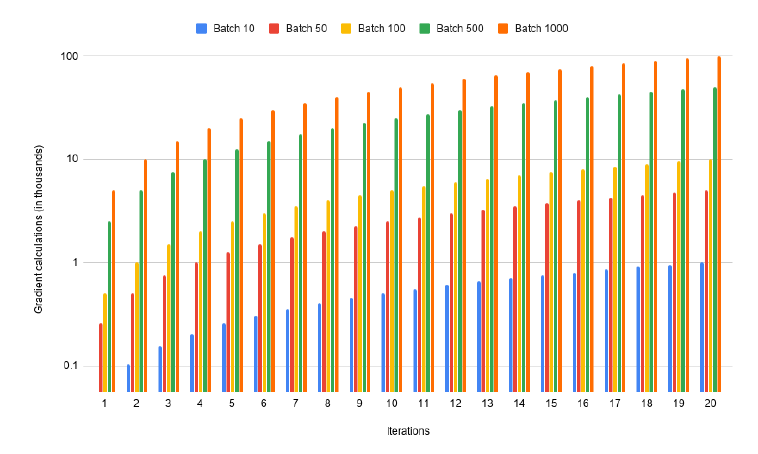
Figure 7. Number of detections done during training of the network with batch 100 and training of the network using modified algorithm with non-informative samples removed.